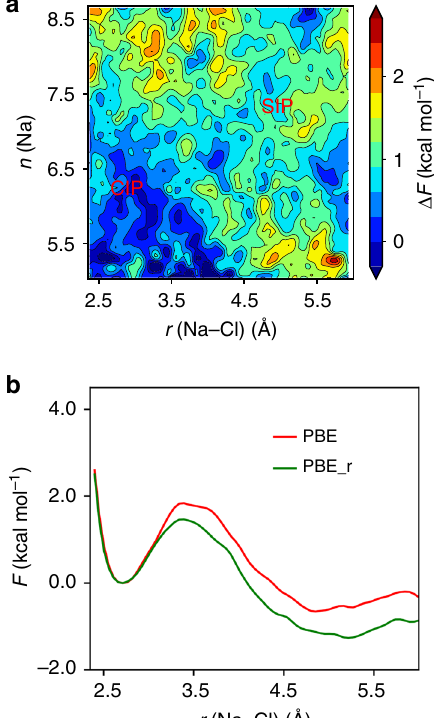
Fig. 7 Impacts of water dissociation on free energy surfaces. a 2D free energy difference, F PBE − F PBE_r , obtained using ab initio simulations of a 0.68 M NaCl solution at 1000 K and 11 GPa with the PBE functional. PBE_r denotes FPMD the results with O – H bond fi xed to 1.0 Å and the positions of CIP and SIP minimum are marked in red. b 1D FESs obtained with (green line) and without (red line) rigid molecules aligned by CIP